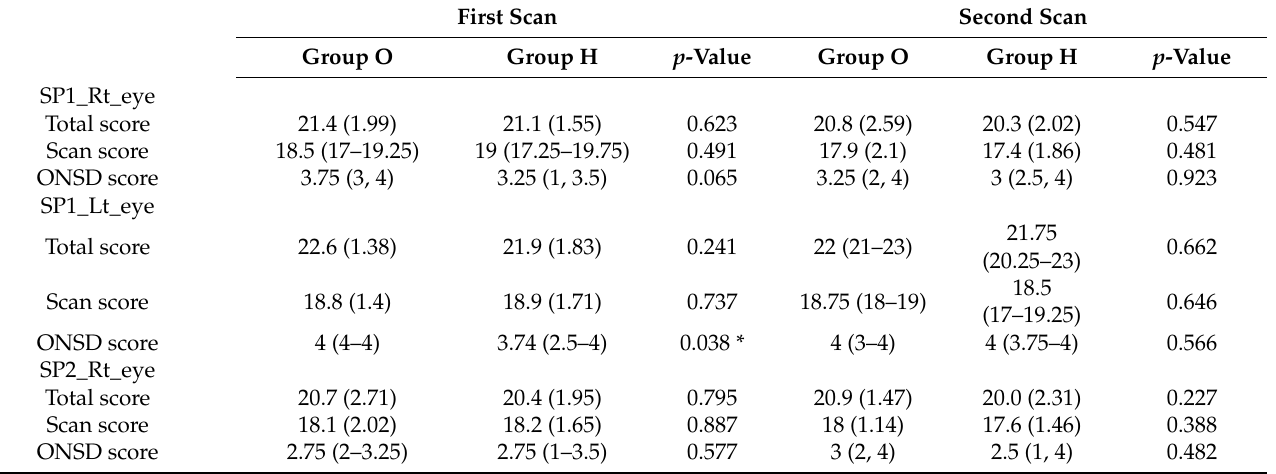
Table A3. The scores of the ocular POCUS scans before